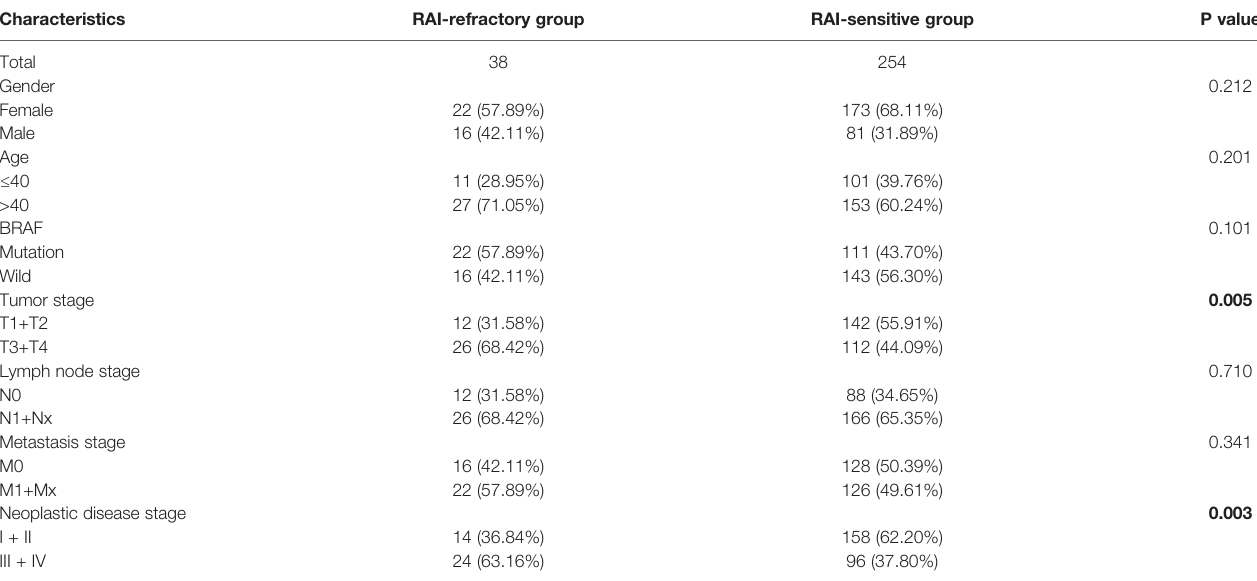
TABLE 1 | Characteristics of PTC patient cohorts with RAI